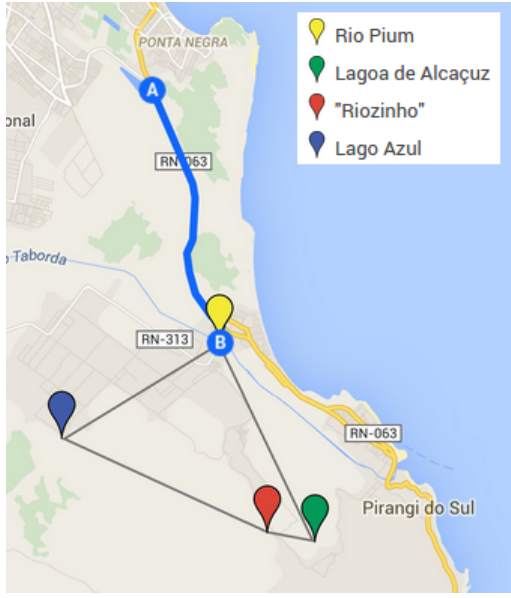
Figure 10. Places for data collection.